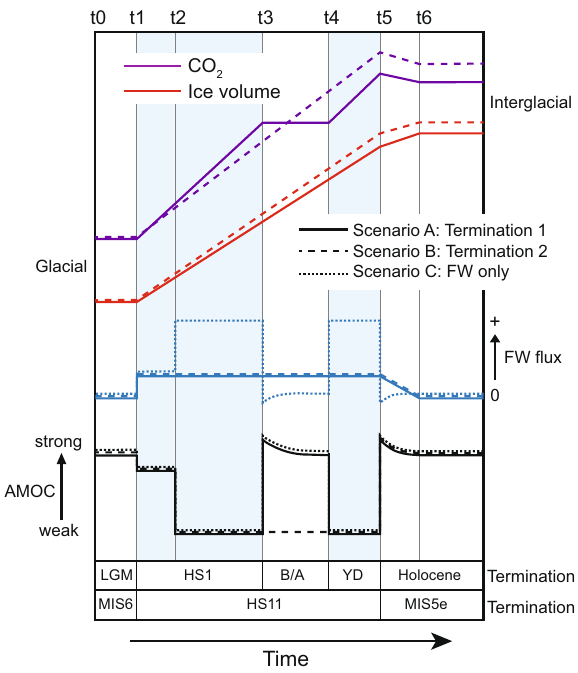
Fig. 6 Deglacial changes in structural stability. Idealised timeseries of CO 2 , ice volume and North Atlantic freshwater (FW) fl ux for last two terminations with corresponding variations in AMOC strength according to text and Fig. 4. Solid curves represent T1; Dashed curves represent T2; Dotted curves represent a scenario for T1 in which variations in the AMOC are forced purely by freshwater (not requiring an underlying structural change in stability). Times t0 – t6 are referred to in